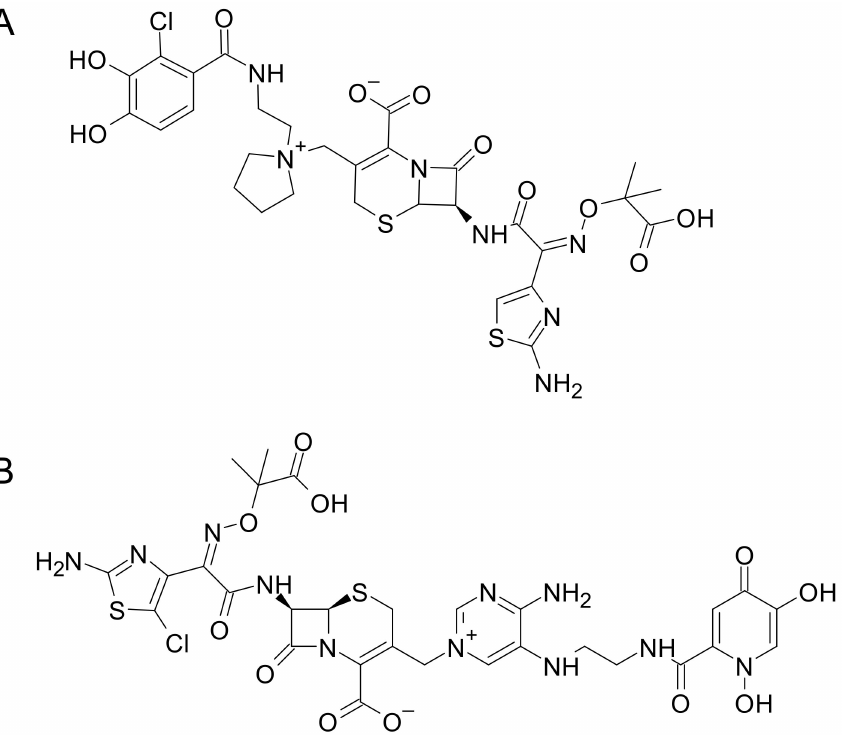
Figure 9. Chemical structures of the siderophore–cephalosporin conjugates, Cefiderocol ( A ) and GT-1 ( B